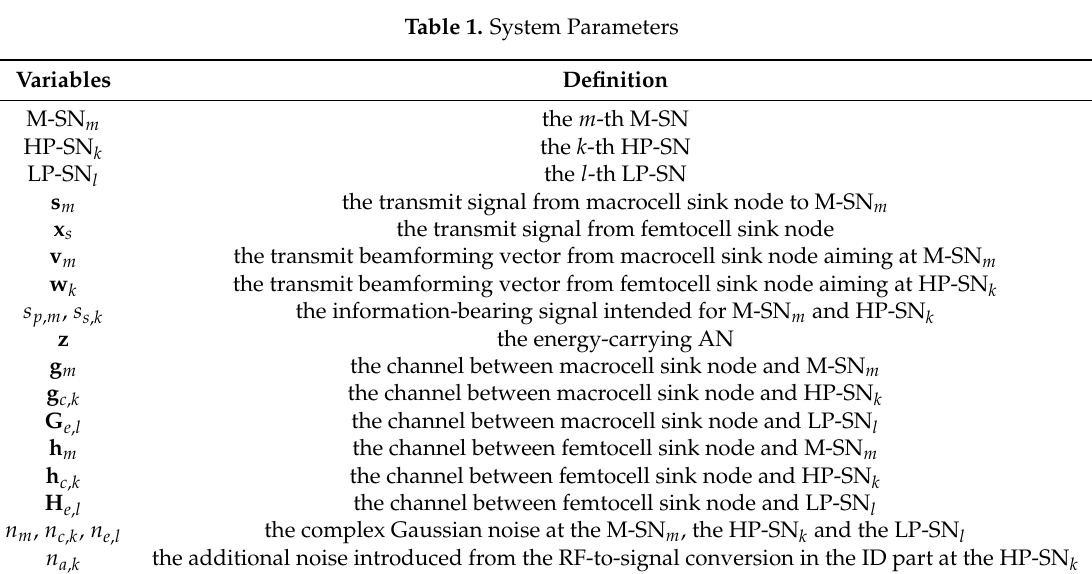
Figure 2. Power splitting scheme in each